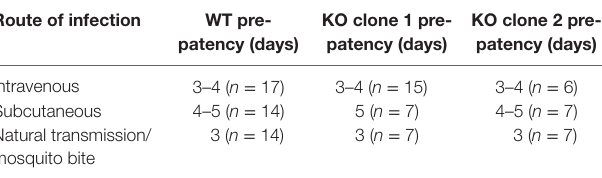
Groups of 5 C57BL/6J mice were infected with 10 4 WT or KO sporozoites intravenously, subcutaneously, or through the natural route of transmission, i.e., infectious bites of 10 mosquitoes. The mice were monitored for blood-stage parasites from 3 days on post-infection (d.p.i.) by microscopic examination of blood